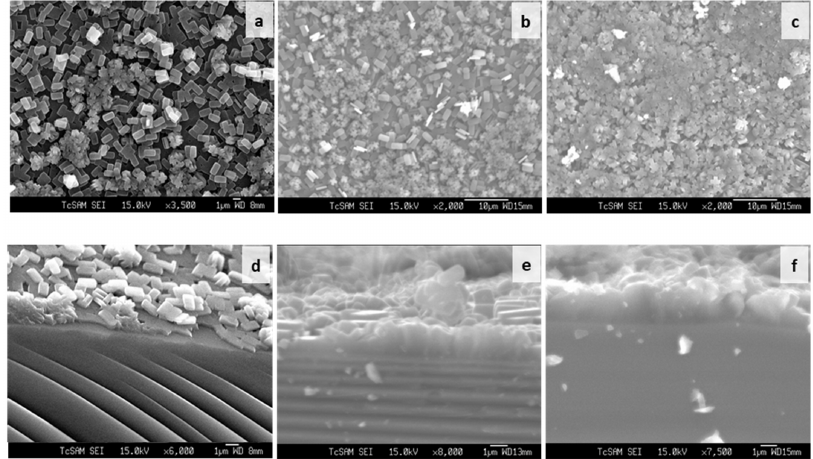
Figure 6. SEM images of silicalite-1 thin-film surface ( a – c ) and cross section ( d – f ) synthesized at 100 °C after 1 day ( a , d ), 3 days ( b , e ), and 5 days ( c , f ) of crystallization.